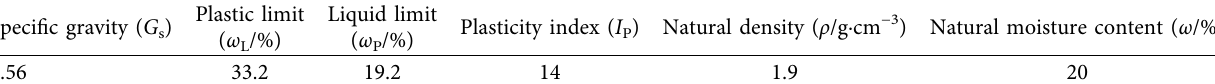
Table 2: Basic physical properties of soil.